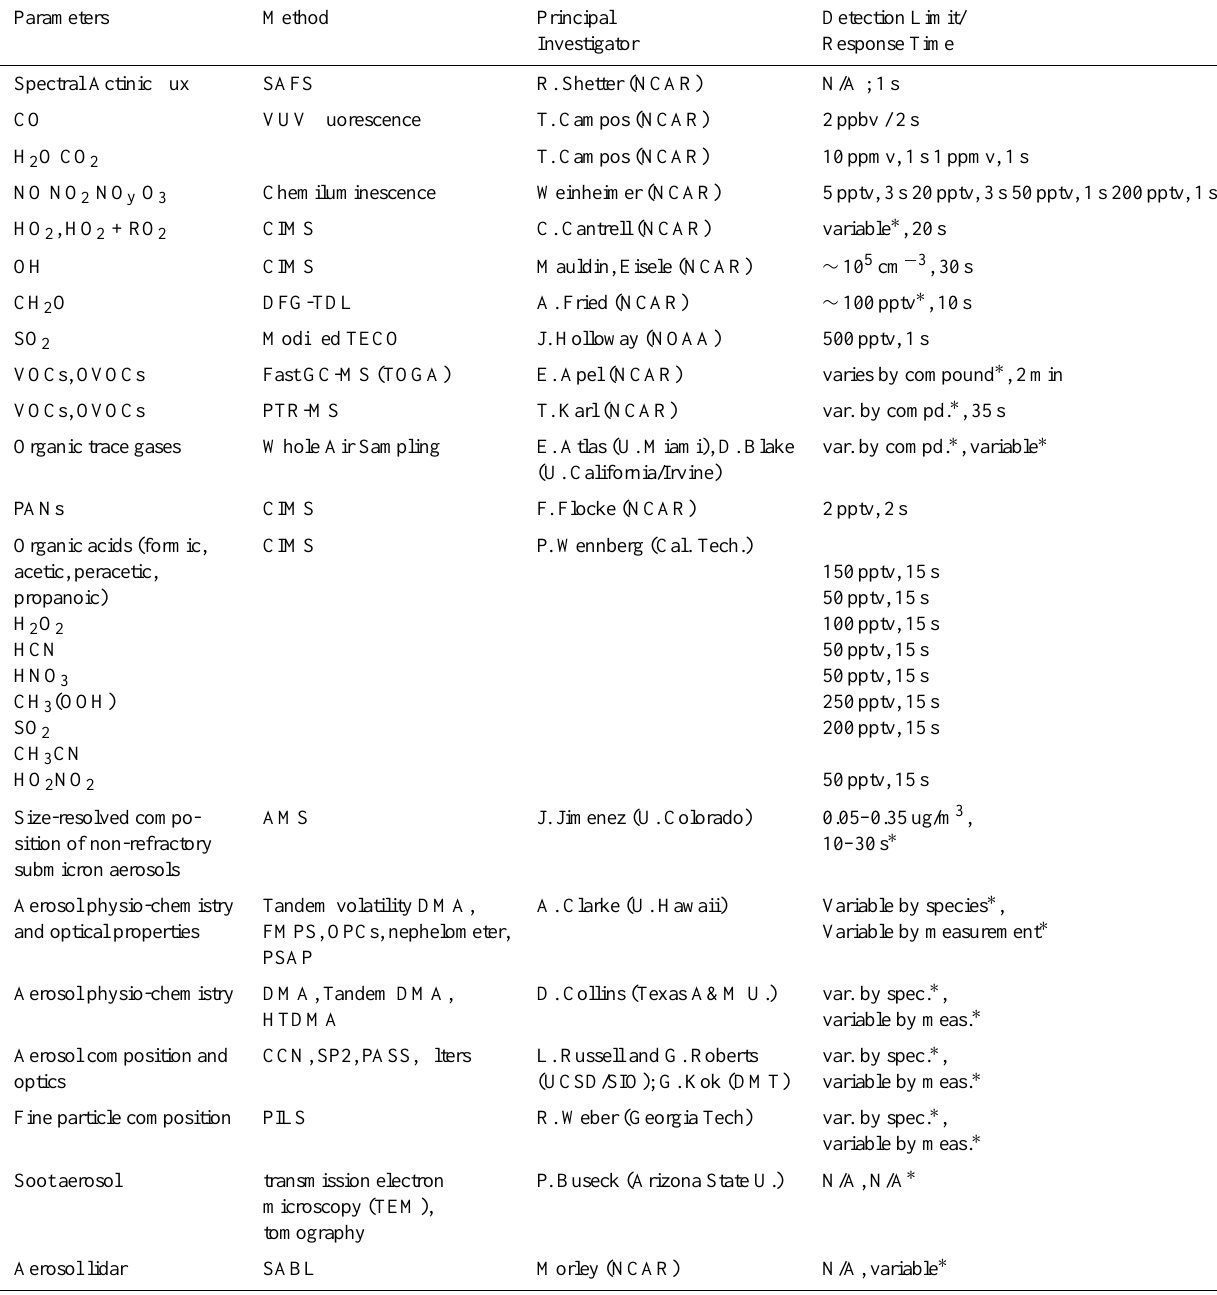
Table 5. C-130 scientific